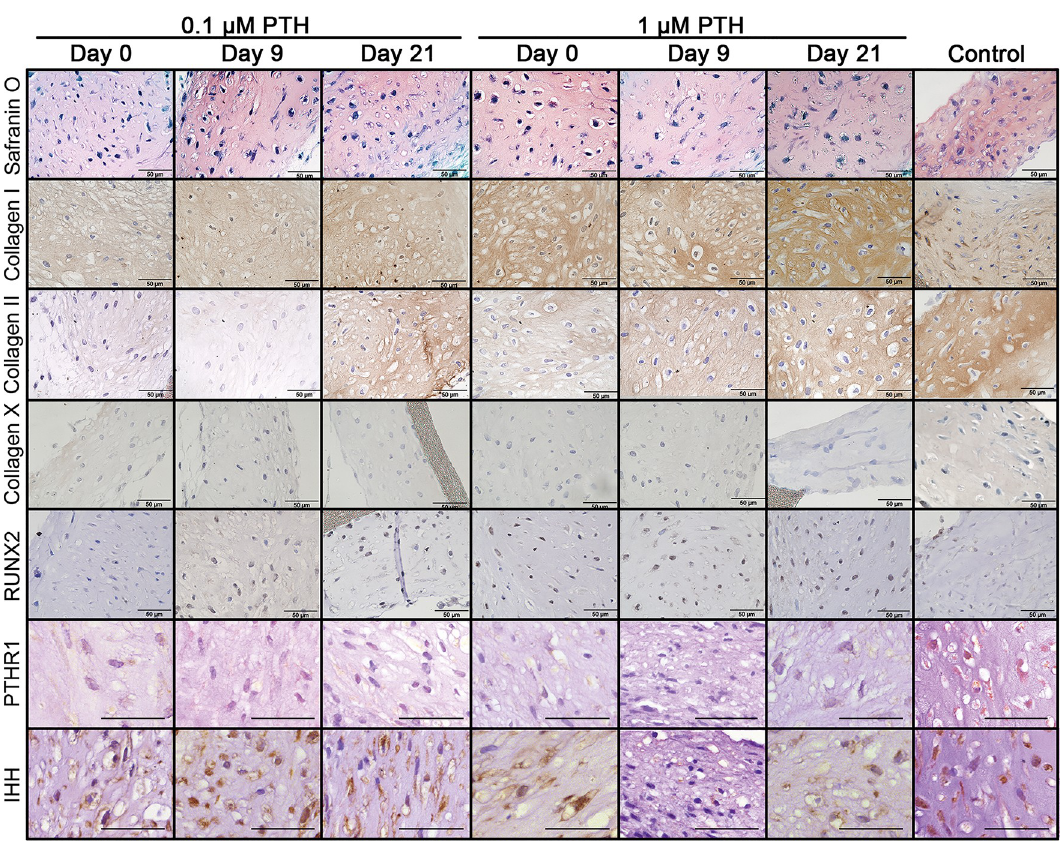
Fig 3. Histological sections of human chondrocytes cultured for 28 days in the presence of 0.1 or 1.0 μ M PTH from day 0, 9 or 21 onwards. Controls did not receive PTH. All scale bar represent 50 μ m. n = 6.